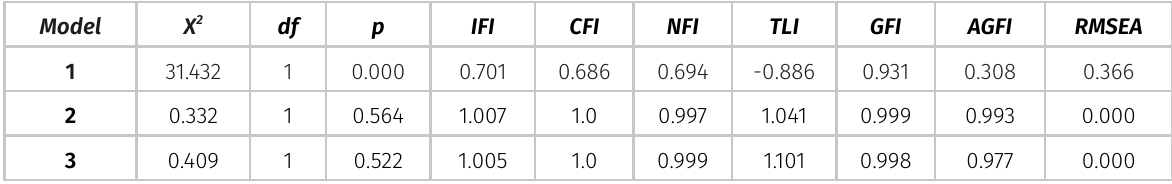
Table IV. Goodness-of-fit statistics of structural models predicting suicide risk and attempt.